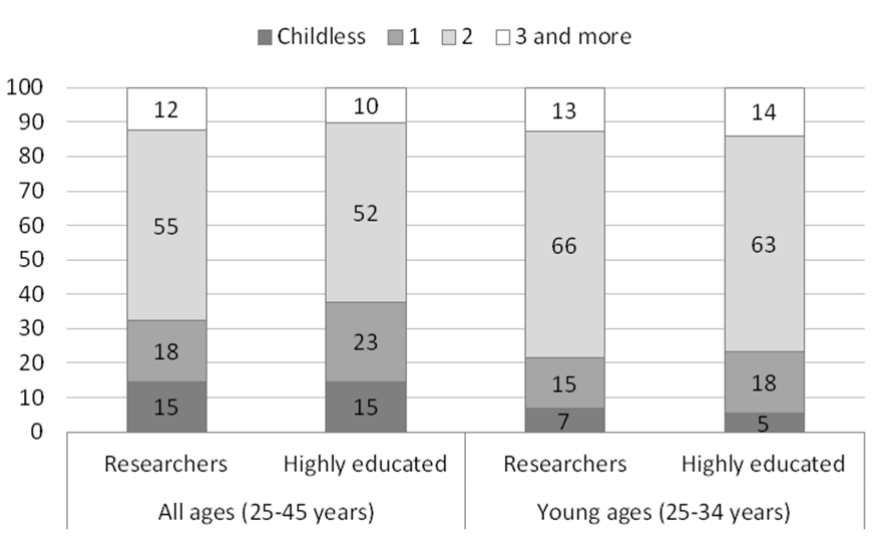
Figure 1 : Intended number of children among childless female researchers and other highly educated women (in